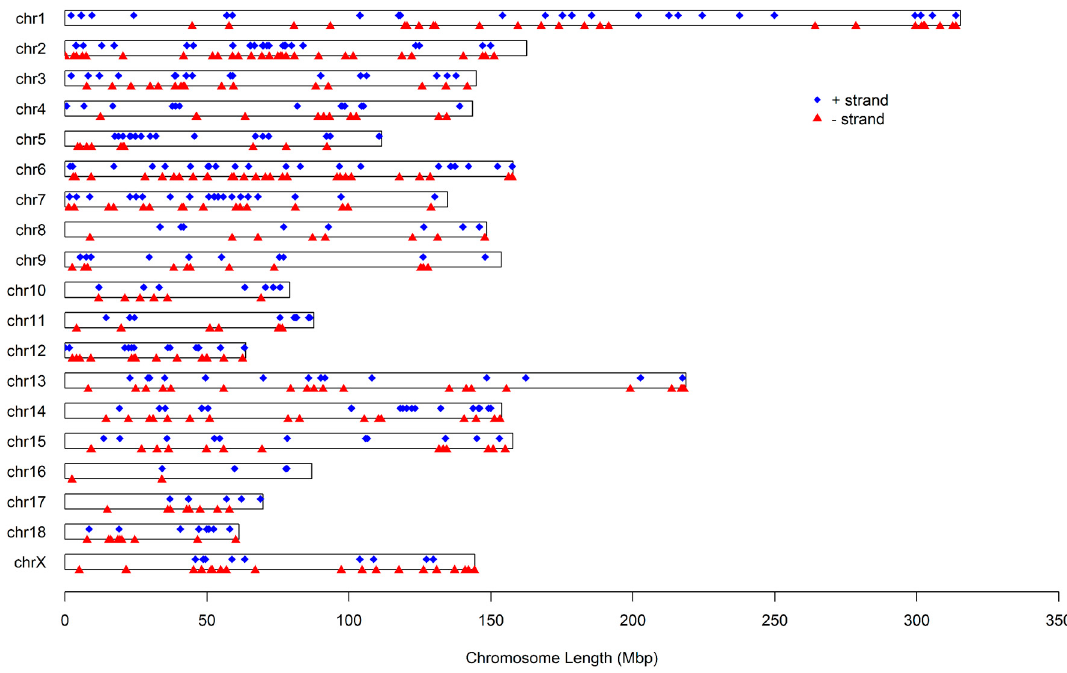
Figure 2. Distribution of miRNAs identified in the study on the chromosomes. Blue diamonds and red rectangles mean + strand and − strand, respectively.